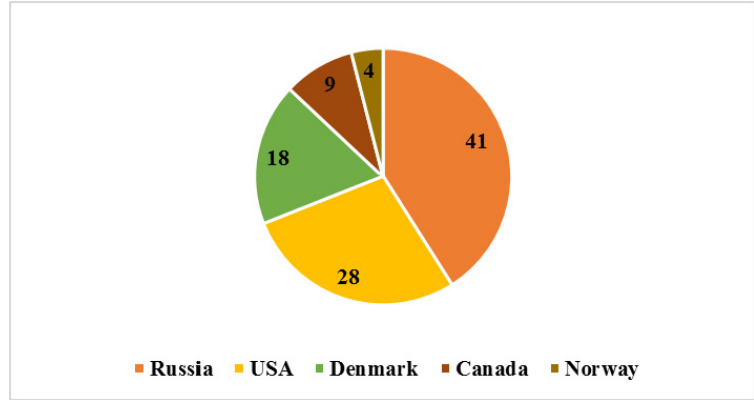
Figure 1. Distribution of undiscovered oil reserves between the Arctic countries, %.